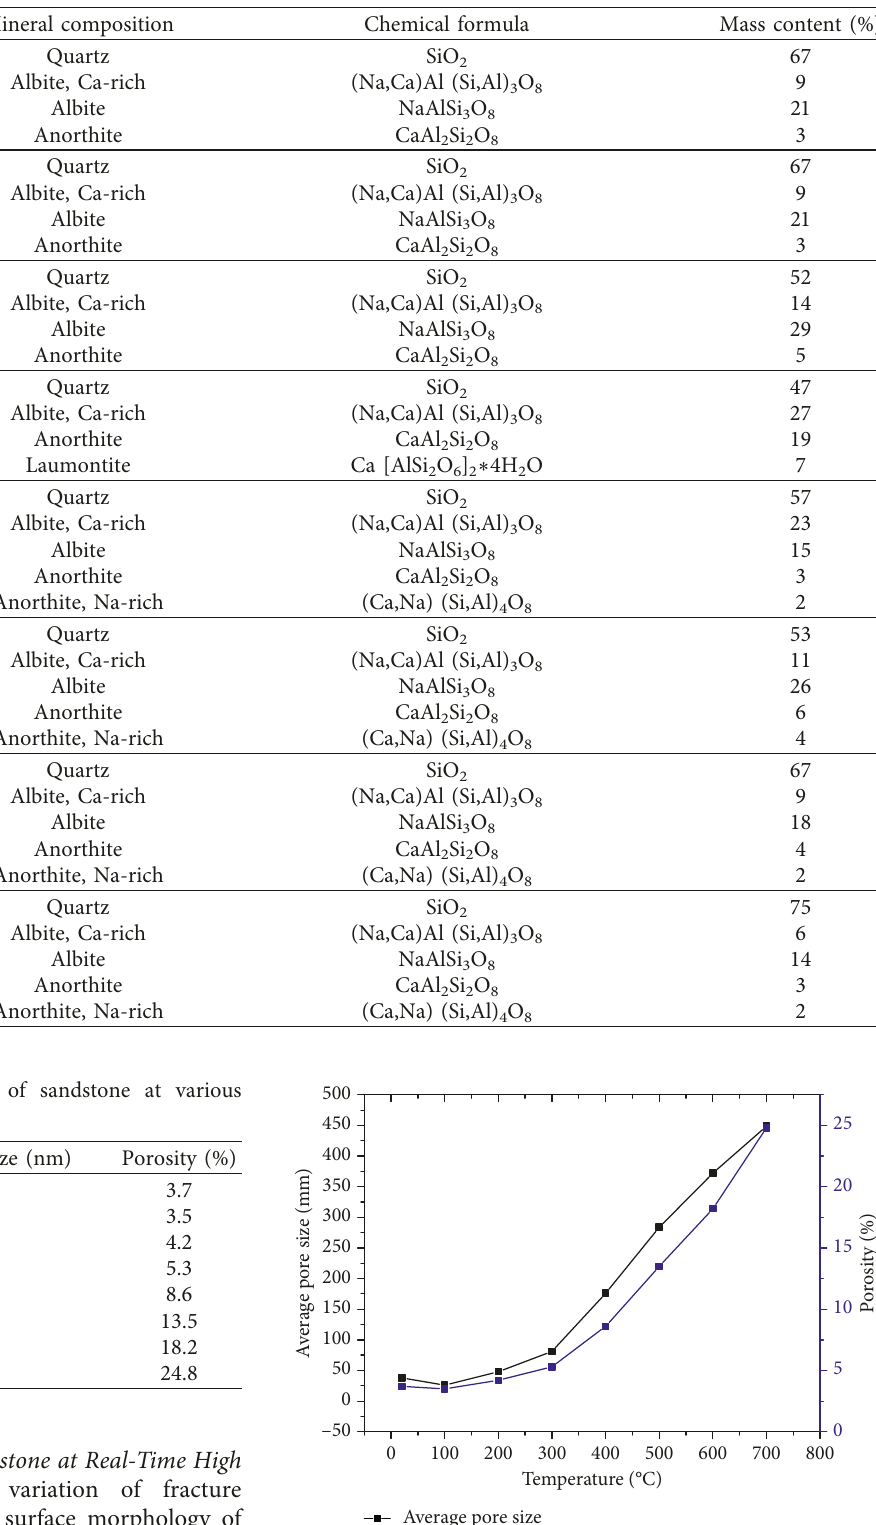
Table 5: The mineral composition and mass content of sandstone at various temperatures.